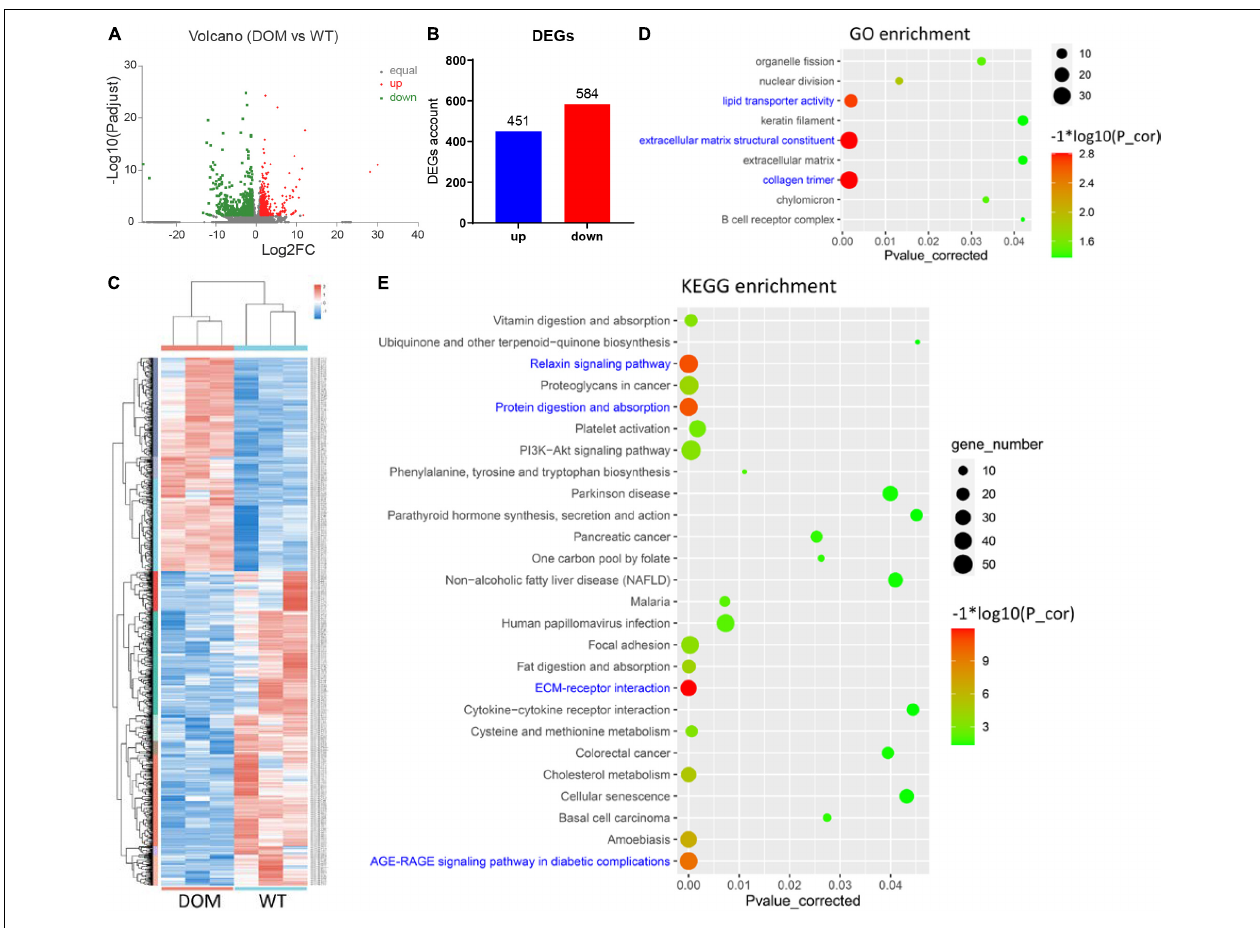
FIGURE 3 | Transcriptomic analysis of A. grunniens intestine domesticated with compound feed. (A) Volcano plot of unigenes; (B) Statistics of differentially expressed genes (DEGs); (C) Heatmap cluster of DEGs; (D) GO annotation of DEGs; and (E) KEGG enrichment of